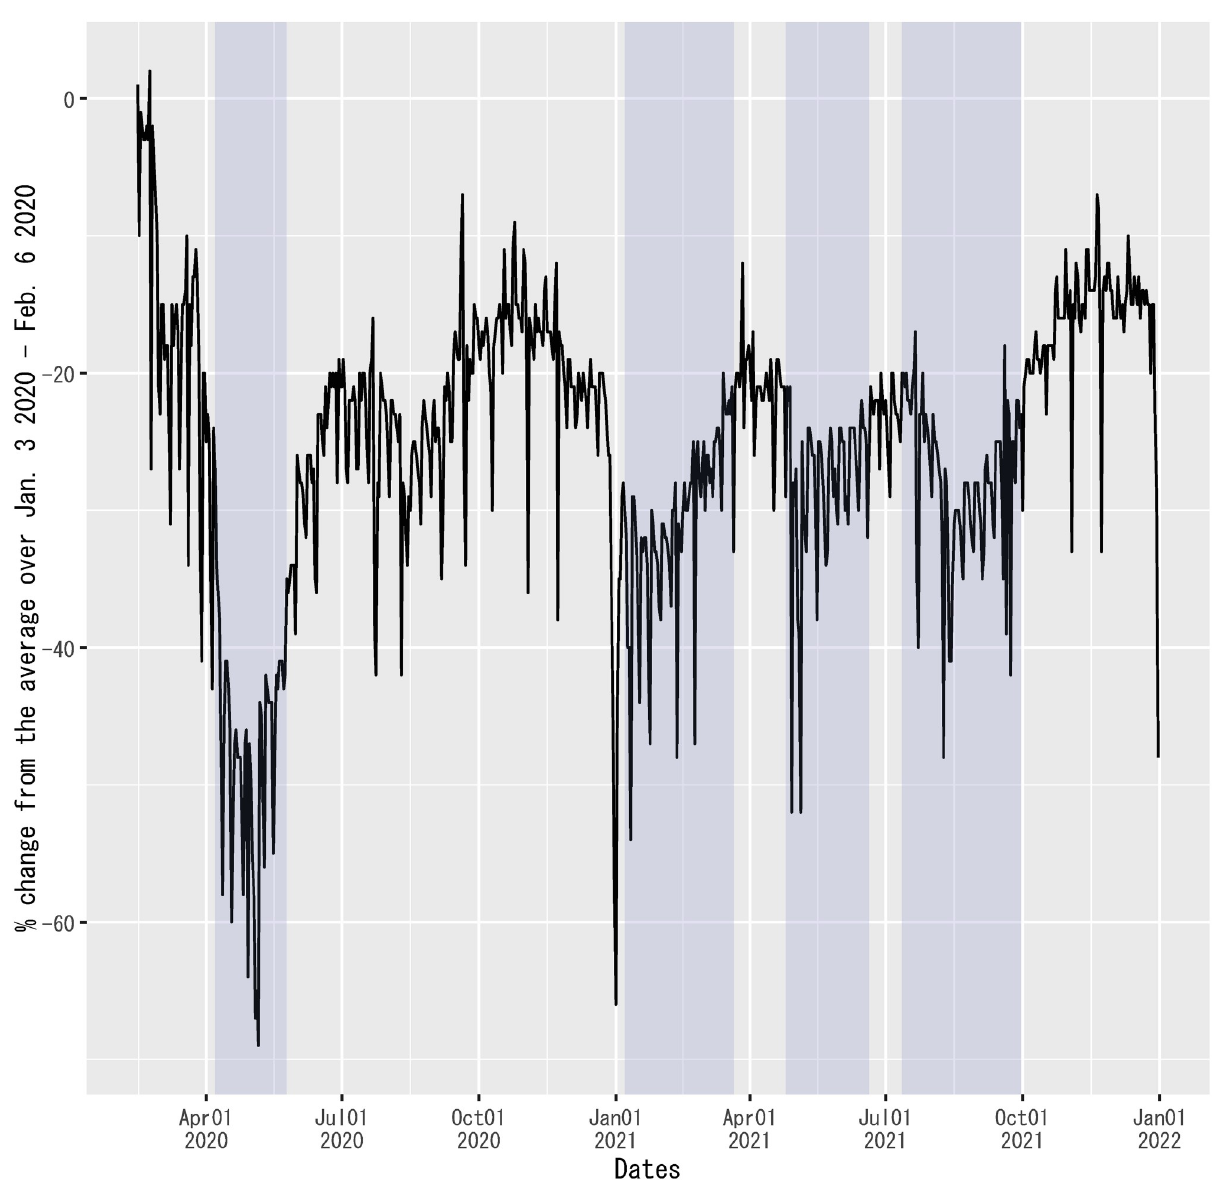
Fig 3. Mobility in public transportation in Japan. The figure shows transit_stations for Japan in the COVID-19 Community Mobility Reports [52]. The sample period shown in the figure is from February 15, 2020, to December 31, 2021. Each shadowed period indicates a state of